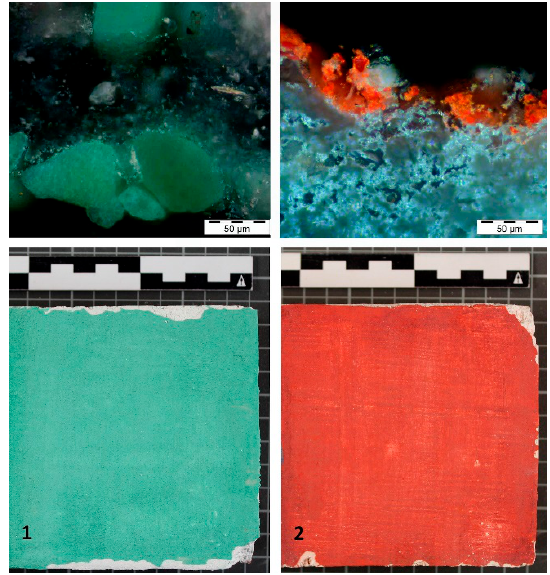
Figure 2. Above: identification of natural malachite and cinnabar in the original layers of the Figure2. Above: identificationofnaturalmalachiteandcinnabarintheoriginallayersoftheplasterwork plasterwork in the Patio de las Doncellas in the Real Alcázar of Seville. Below: general image of the in the Patio de las Doncellas in the Real Alc á zar of Seville. Below: general image of the chromatic study chromatic study surface of the probes. surface of the